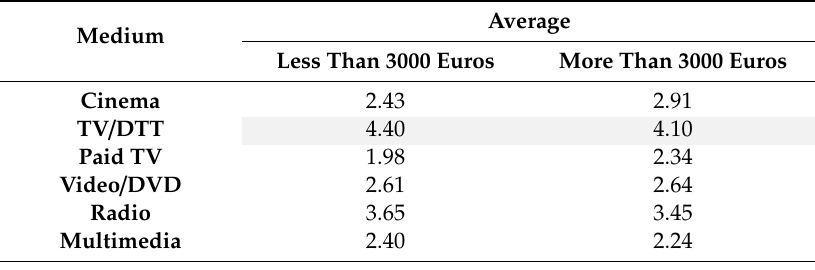
Table 8. Audiovisual consumption according to monthly income (averages).